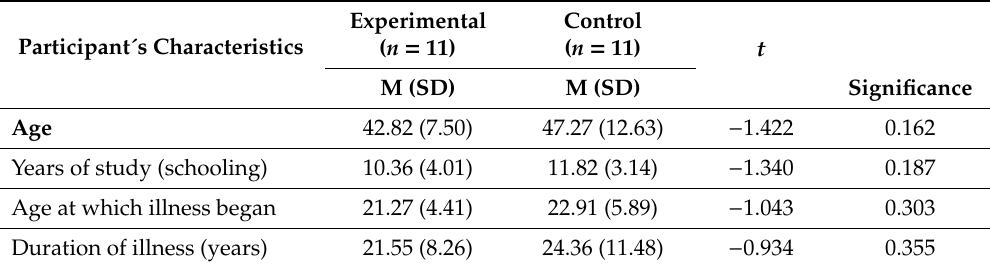
Table 1. Participants’ sociodemographic and clinical characteristics. Di ff erences between the experimental and control